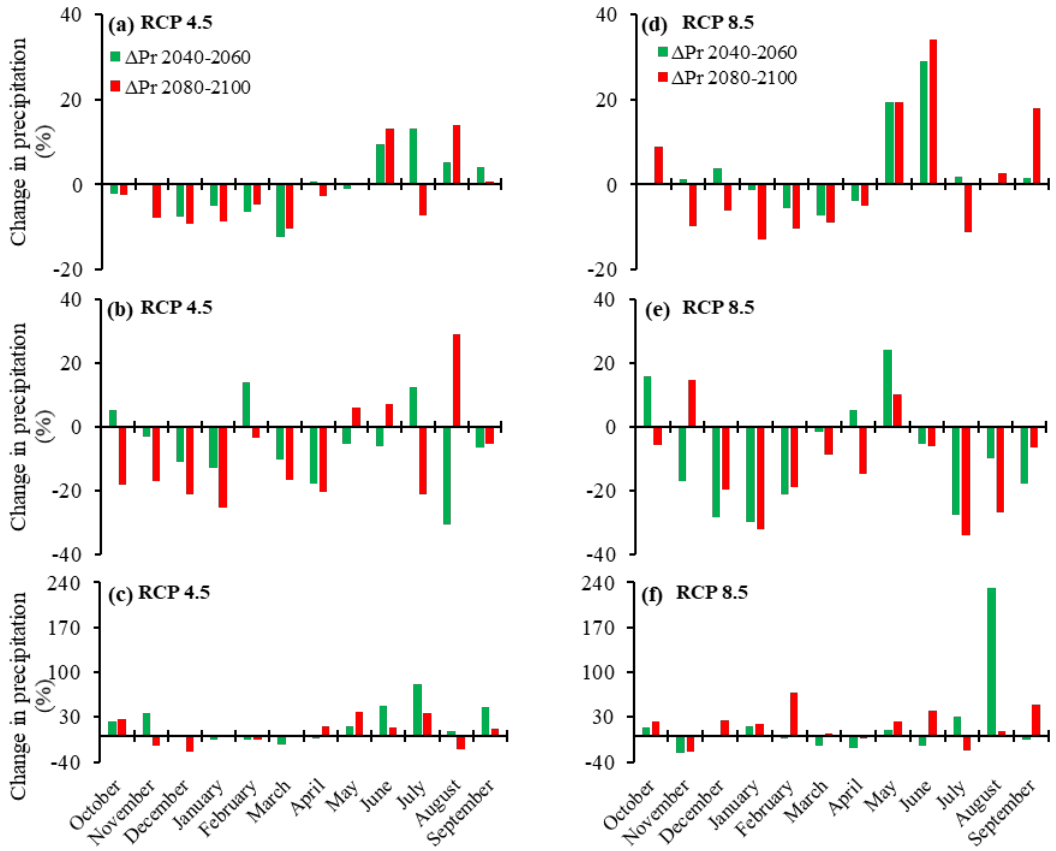
Figure 5. Projected monthly precipitation changes during 2040–2060 and 2080–2100: ( a ) average, ( b ) lower, and ( c ) higher under RCP 4.5; and ( d ) average, ( e ) lower, and ( f ) higher under RCP 8.5.